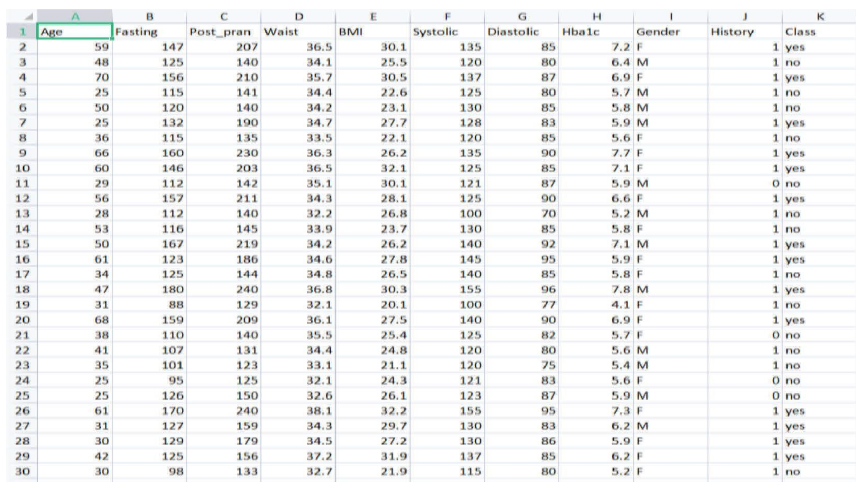
Figure 2: Survey dataset.